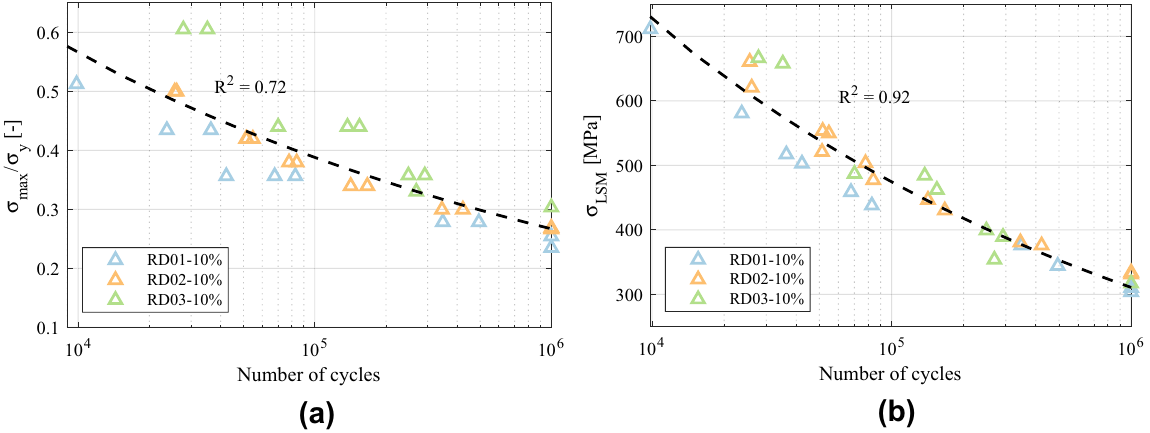
Figure 14. S–N curves of 10% stiffness loss criterion normalized by ( a ) yield strength and ( b ) Local Stress Method.